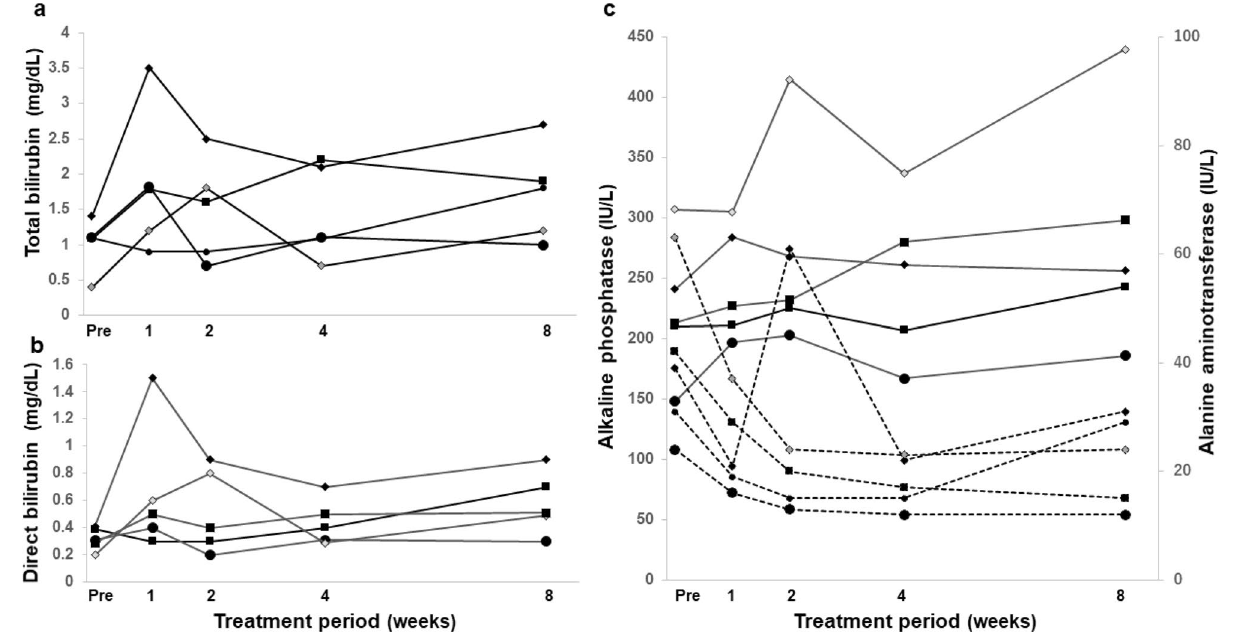
Figure 1. Time course of ( a ) total and ( b ) direct bilirubin concentration and ( c ) alanine aminotransferase and alkaline phosphatase in five patients treated with glecaprevir who developed grade ≥ 2 hyperbilirubinemia. Black line, total and direct bilirubin and alkaline phosphatase; dotted line, alanine aminotransferase.